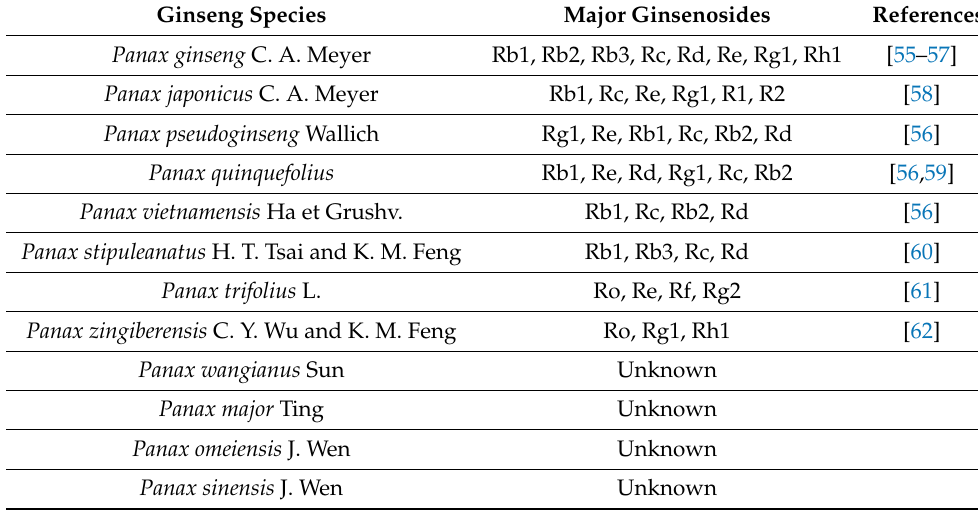
Table 2. Ginseng species and their major